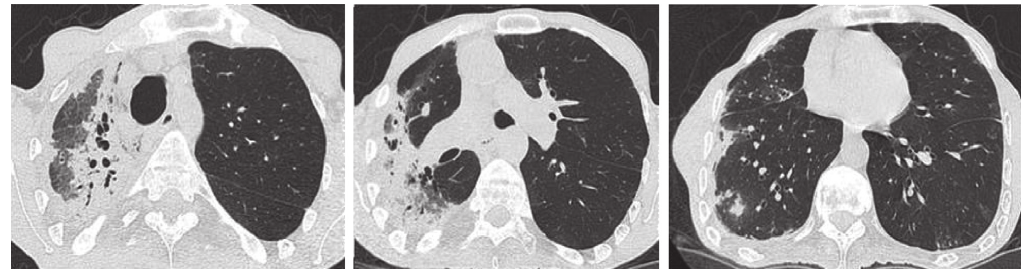
Figure 2: Thorax HRCT performed in 2019. It shows chronic consolidation with traction bronchiectasis compatible with fibrosis in the apical and posterior segments of the upper lobe which is extending to the superior segment of the lower lobe. Nodular alveolar densities in the lateral basal segment of the right lower lobe are also